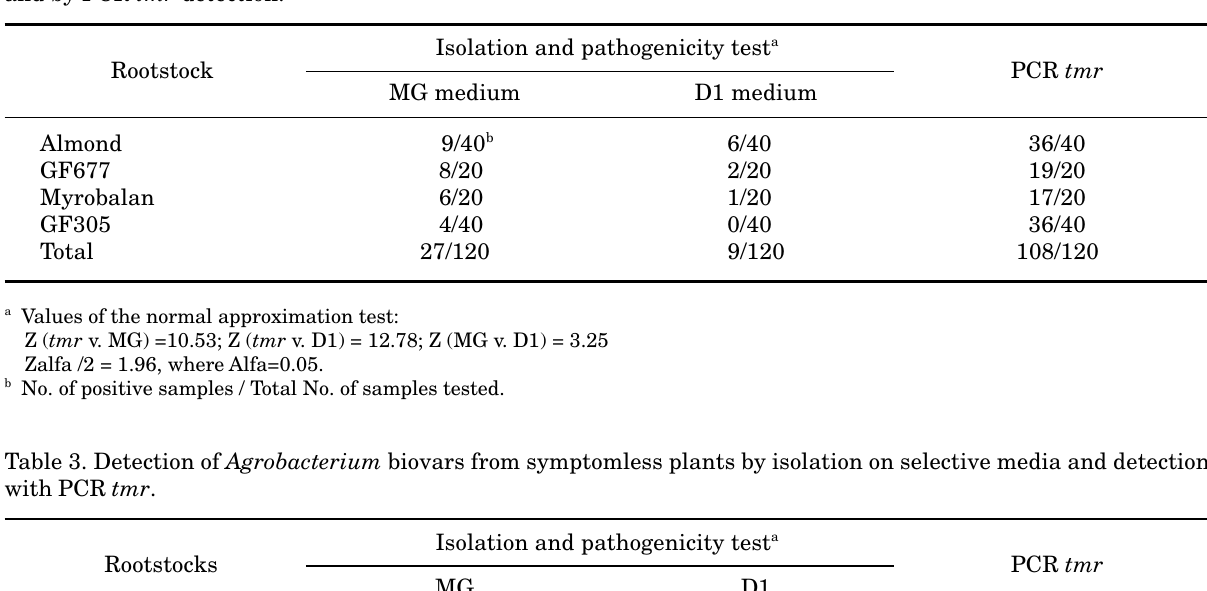
Table 2. Detection of Agrobacterium biovars from tumors of naturally infected plants by isolation on selective media and by PCR tmr detection.